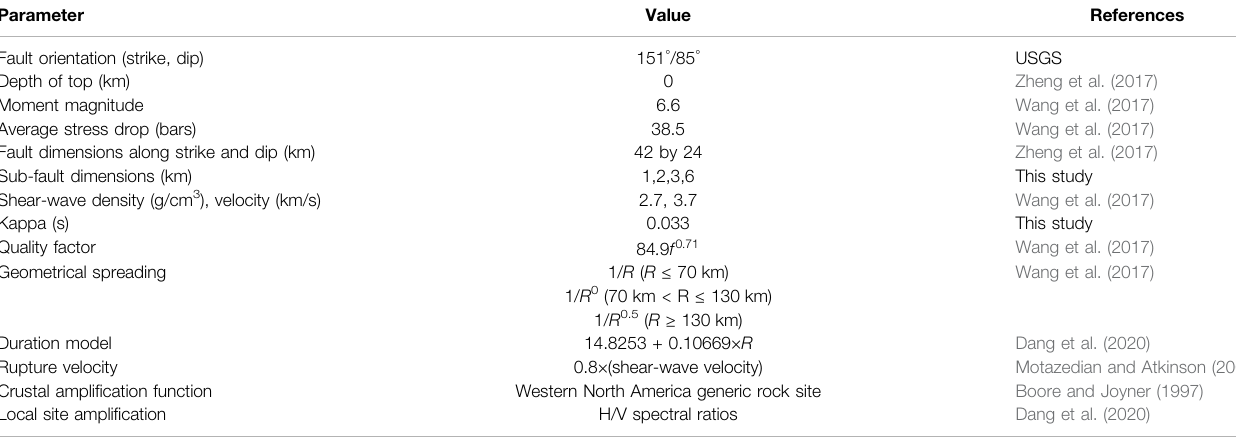
TABLE 1 | Input parameters for the simulation of the Jiuzhaigou earthquake (Dang et al., 2020).